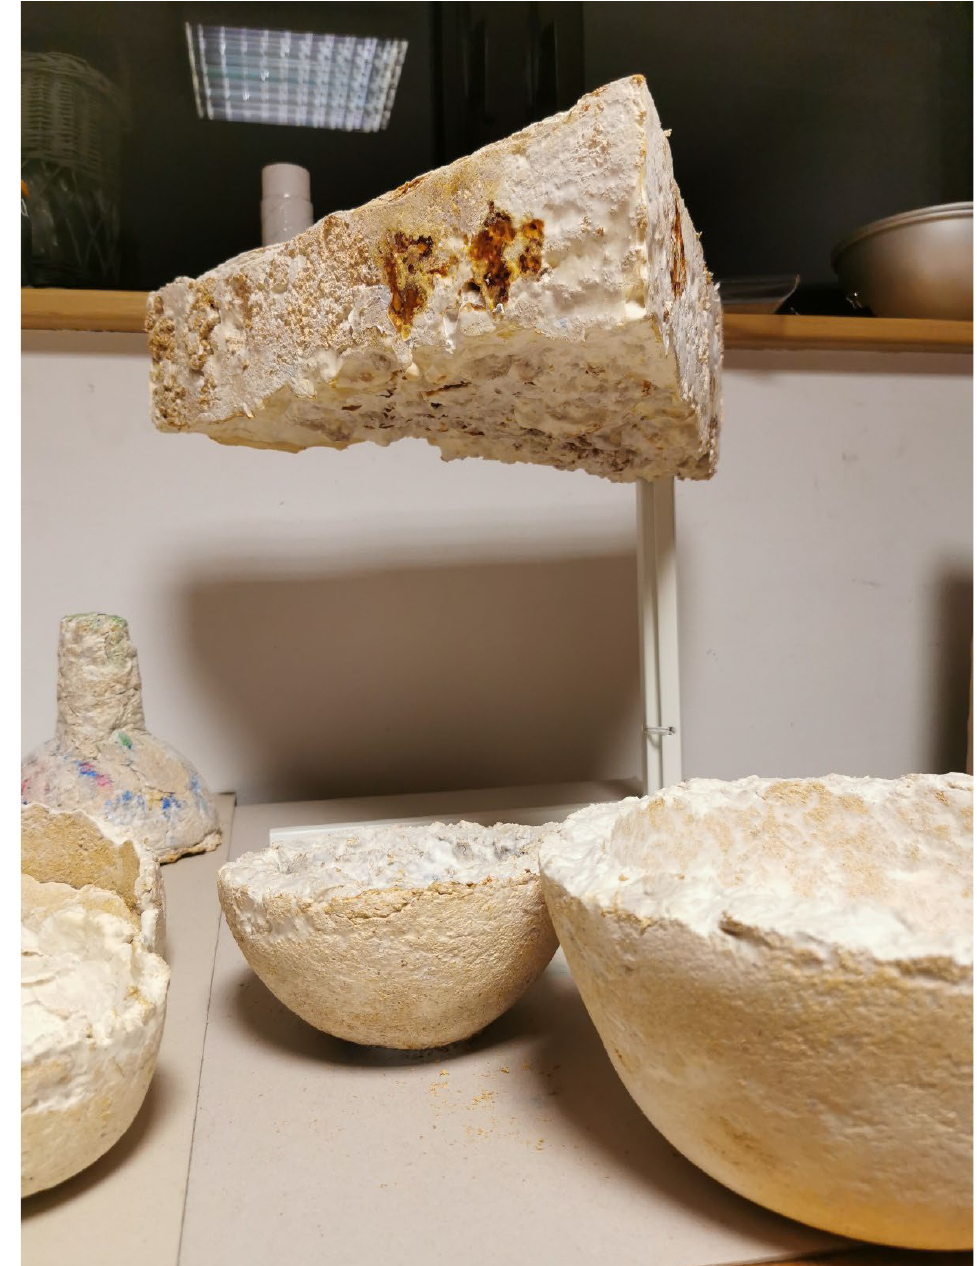
Figure 5. Various artefacts made with MBC: coffee-table, bowls, lampshades based on hemp mix with Ganoderma lucidum (artefact production and photo A. Bonenberg).